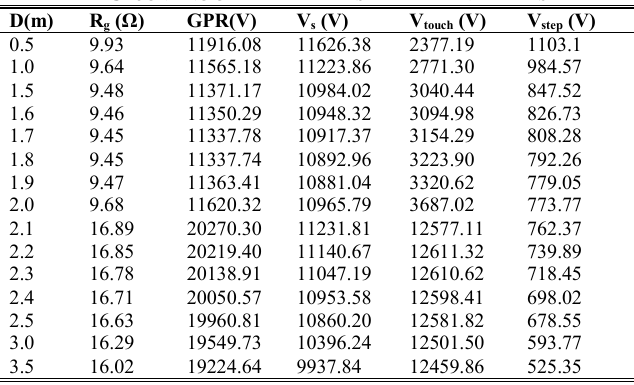
TABLE III G ROUNDING GRID PARAMETERS AT DIFFERENT DEPTHS